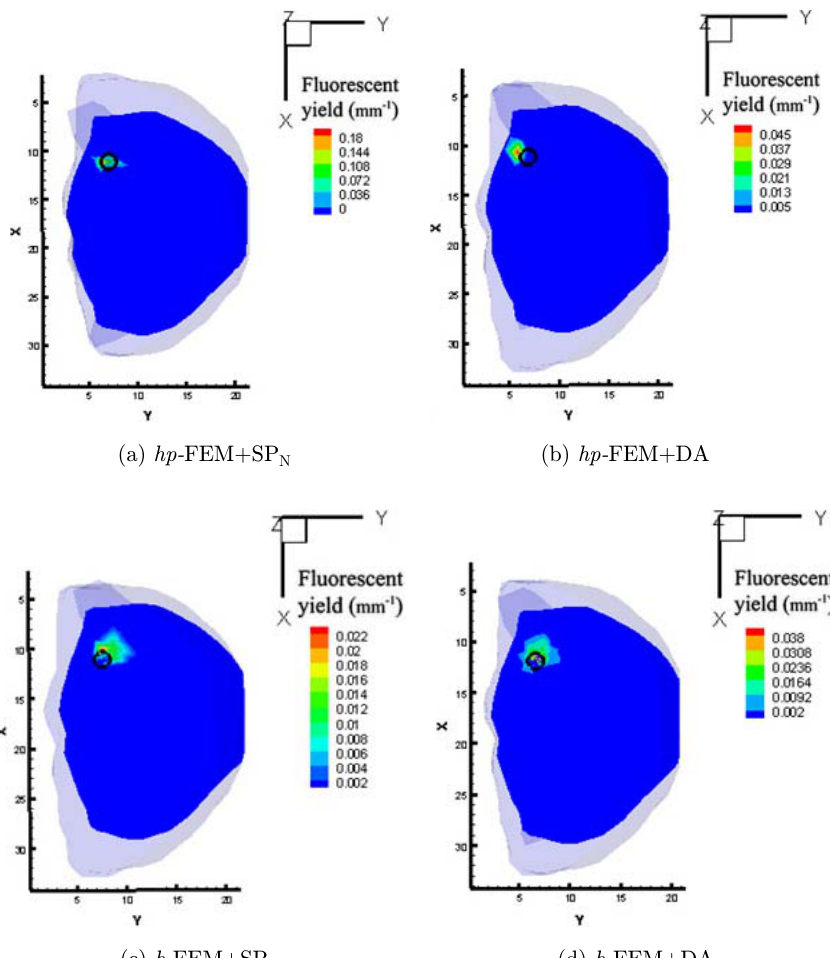
Fig. 4. A comparison of hp- FEM and h -FEM on di®erent forward model. (a) and (c) are the transverse views of the reconstruction result using hp- FEM and h -FEM on the SP N model. (b) and (d), are the corresponding results of them on the DA